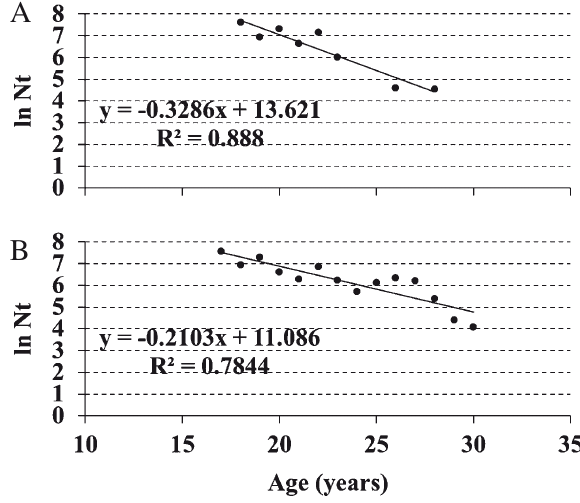
f iG . 8. – Catch curve based on 2011 data for females (A) and males